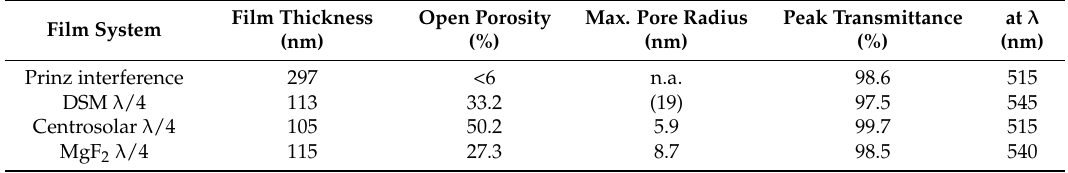
Table 2. Film thickness, open porosity, maximum of pore radius distribution, and peak transmittance of antireflective coatings under investigation. Reproduced from Reference [42] with the permission of the Royal Chemical Society.